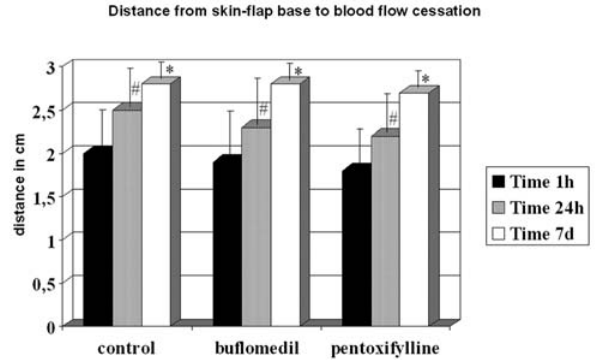
Figure 4 - Distance from the skin flap base to blood flow cessation in the control, Buflomedil, and Pentoxifylline groups. These groups were evaluated 1 (Time 1h) and 24 (Time 24h) hours and 7 (Time 7d) days after skin flap preparation. *,# p < 0.05 compared to Time